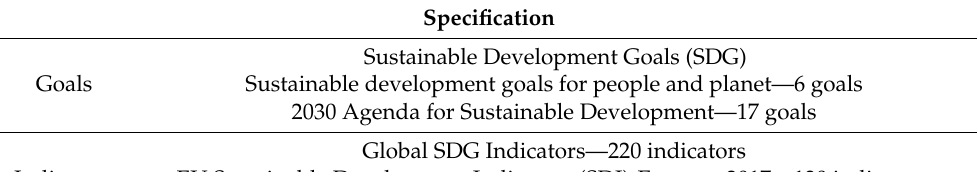
Table 1. Overview of approaches to the definition of sustainable